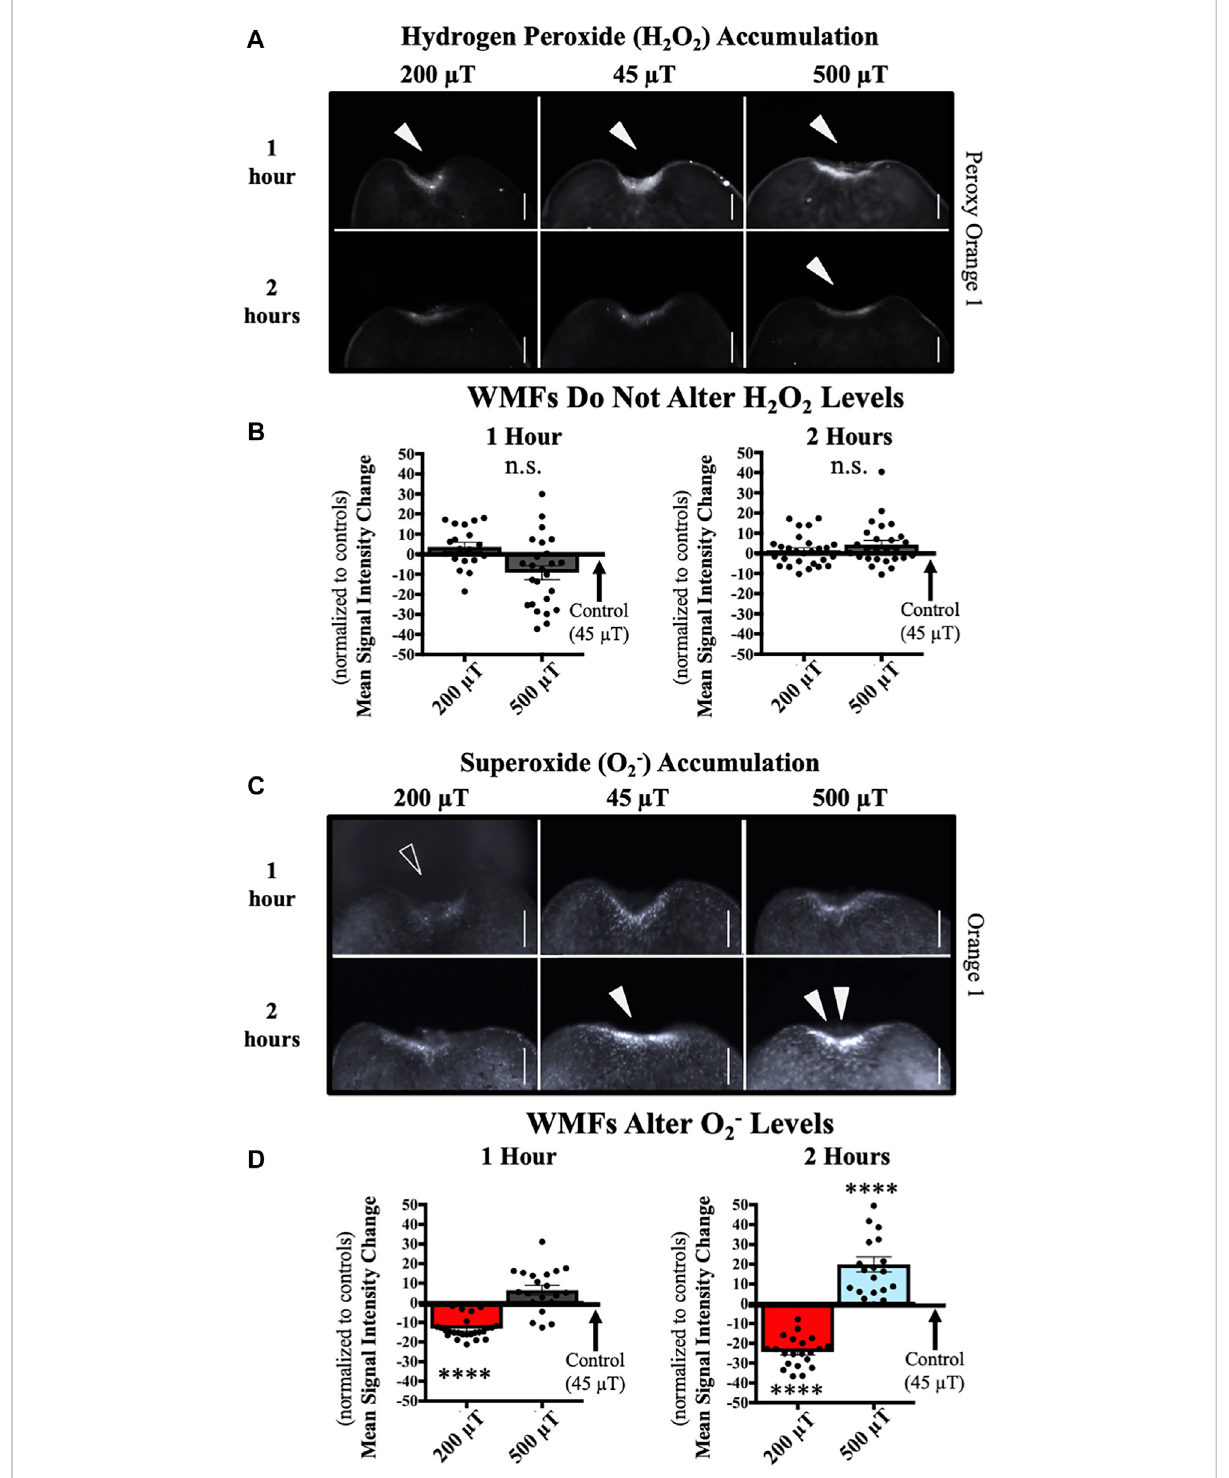
FIGURE 5 WMFs Alter Superoxide (O 2 − ) but not Hydrogen Peroxide (H 2 O 2 ) Levels. WMF effects (at the anterior wound site) from 200 µT or 500 µT exposure (as compared to 45 µT controls), as shown at 1 h and 2 h after injury. (A) H 2 O 2 accumulation visualized by peroxy orange 1 live fl uorescent dye. Solid arrows = peak of accumulation. (B) Quanti fi cation of (A) , showing no change in levels as compared to 45 µT controls. n ≥ 19. n.s. = not signi fi cant. (C) O 2 − accumulation visualized by orange 1 live fl uorescent dye. Open arrow = loss of accumulation. Solid arrow = peak